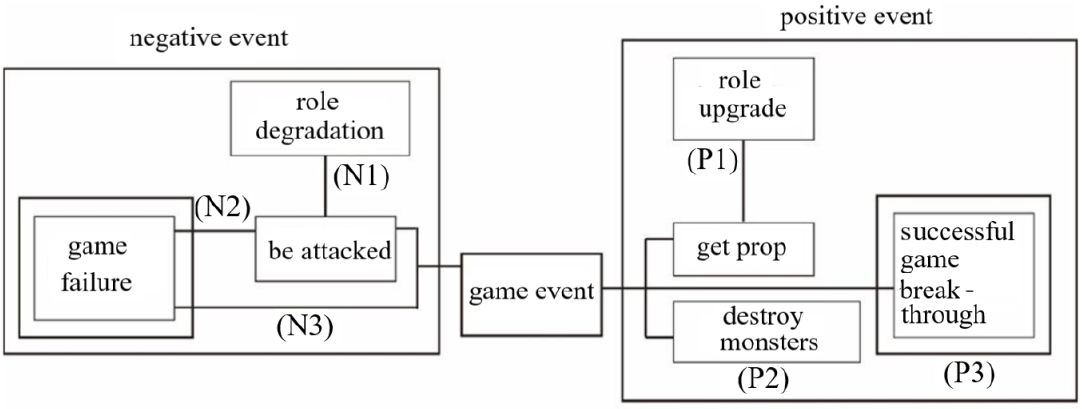
Figure 5. Game events listed in the subjective questionnaire. Russell’s valence-arousal (V-A) model is referenced for the emotion evaluation. In this model, V as a horizontal axis indicates the degree of emotional pleasure, and A as a vertical axis indicates the degree of emotional arousal. After referring to the discrete emotion classification, four poles of the two-dimensional emotion classification model are extracted, and are used to represent four emotions: fatigue, tension, happiness, and sadness. Table 1. Six game events.